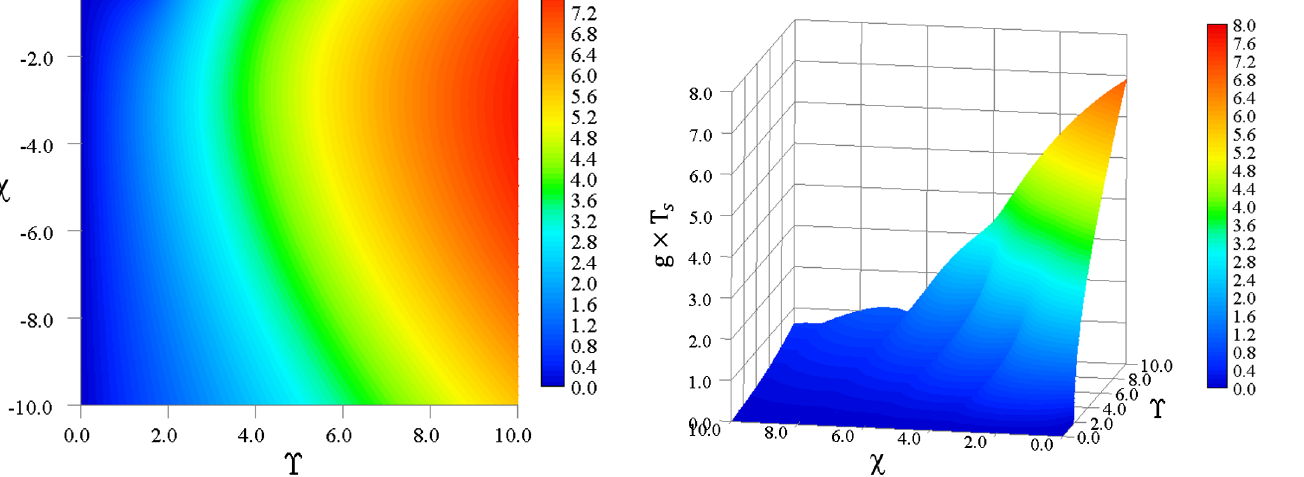
(of FIG. 18. The three-dimensional contour plot of the growth s factor g × T as a function of ϒ and χ at the rms bunch length of s 4 cm in the trapezoidal wake model for the Vlasov analysis with the Gaussian bunch